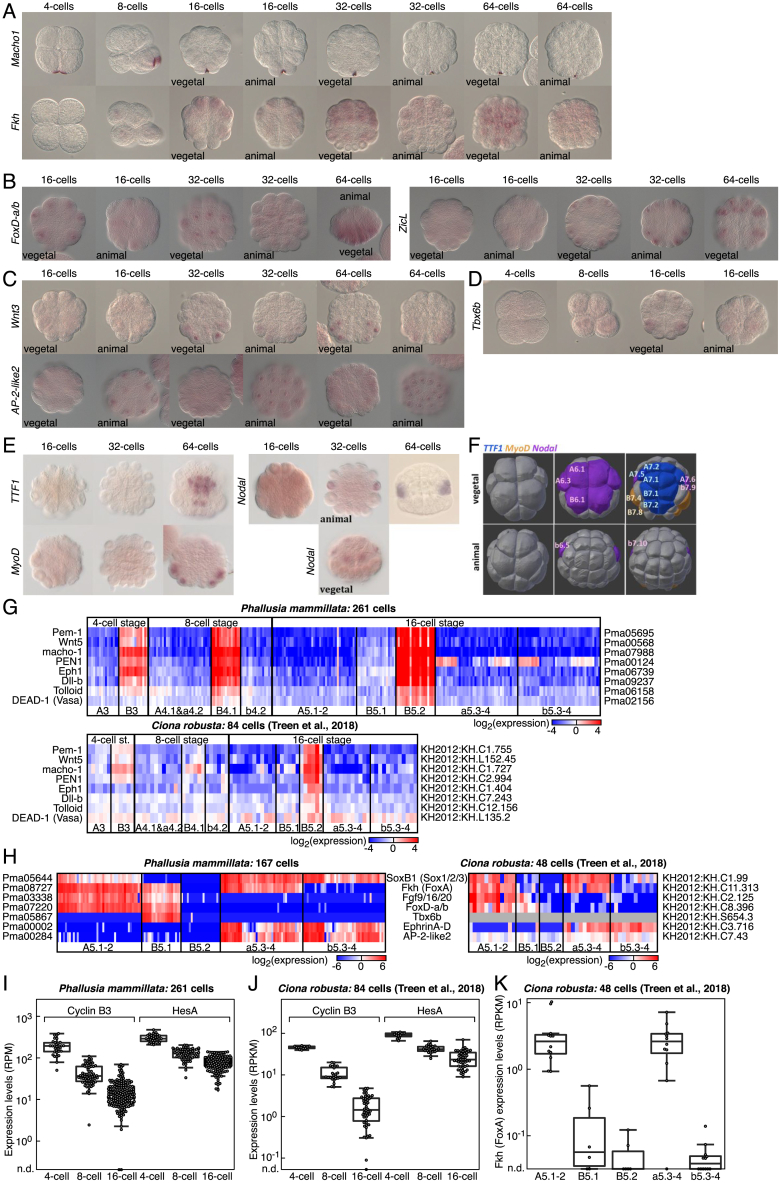
Validation of the Spatial Mapping of Single-Cell Gene Expression Profiles, Related to Figure 4(A) Whole mount in situ hybridization of expression profiles of Macho1 and Fkh at 4- to 64-cells stages.(B) Whole mount in situ hybridization of expression profiles of FoxD-a/b and ZicL at 16- to 64-cells stages.(C) Whole mount in situ hybridization of expression profiles of Wnt3 and AP-2-like2 at 16- to 64-cells stages.(D) Whole mount in situ hybridization of expression profiles of Tbx6b at 4- to 16-cells stages.(E) Whole mount in situ hybridization of expression profiles of TTF1, MyoD and Nodal at late 16-cells, late 32-cells and 64-cells stages (vegetal poles are shown unless indicated.(F) Cell identity of cells expressing TTF1, MyoD and Nodal represented in segmented embryos. Vegetal and animal indicate the hemisphere view of the embryo.(G) Expression levels of maternal factors asymmetrically inherited in the germ cell lineage (cells B3, B4.1 and B5.2) as measured by scRNA-Seq in Phallusia mammillata and Ciona robusta (Ciona robusta data is from Treen et al., 2018). All these factors are known to be asymmetrically partitioned from 4-cell stage onward (and 16-cell stage for DEAD-1) in Ciona robusta (Sardet et al., 2005). Phallusia gene IDs are identical to the ones from http://digitalembryo.org.(H) Expression levels of marker genes in 16-cell stage cells as measured by scRNA-Seq in Phallusia mammillata and Ciona robusta (Ciona robusta data is from Treen et al., 2018). Tbx6b was not detected in Ciona robusta by scRNA-Seq by Treen et al. (2018) although Treen et al. (2018) could detect it by qPCR in embryos and by whole mount in situ hybridization in B5.1 cells. Phallusia gene IDs are identical to the ones from http://digitalembryo.org.(I, J) Expression levels of CyclinB3 and HesA in 4- to 16-cell stage cells as measured by scRNA-Seq in Phallusia mammillata (I) and Ciona robusta (J) (Ciona robusta data is from Treen et al., 2018, RPM: reads per million mapped reads, RPKM: reads per kilo base per million, n.d.: not detected).(K) Expression levels of the forkhead transcription factor Fkh (FoxA) in 16-cell stage cells of Ciona robusta (Ciona robusta data is from Treen et al., 2018, n.d.: not detected).